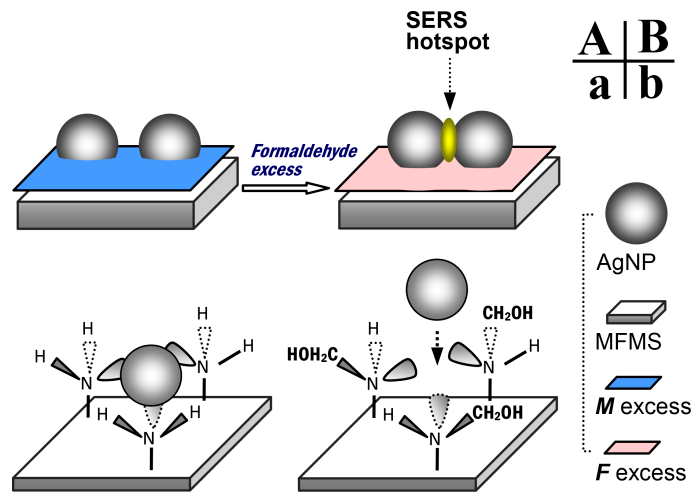
Figure 5. A possible explanation for the formation of SERS hot spot on the AgNP/MFMSs. ( A ) and ( a ): Strong complexing of –NH– in –NH 2 group to AgNP on the MFMS with melamine excess, the AgNPs were anchored on the surface of the MFMS; ( B ) and ( b ): Weak complexing of –NH– in –NHCH 2 OH group, with an additional steric hindrance from the –CH 2 OH to AgNP on the MFMS with formaldehyde excess, thus allowing the two AgNPs to sufficiently interact with each other to form a SERS hot spot [12,13].